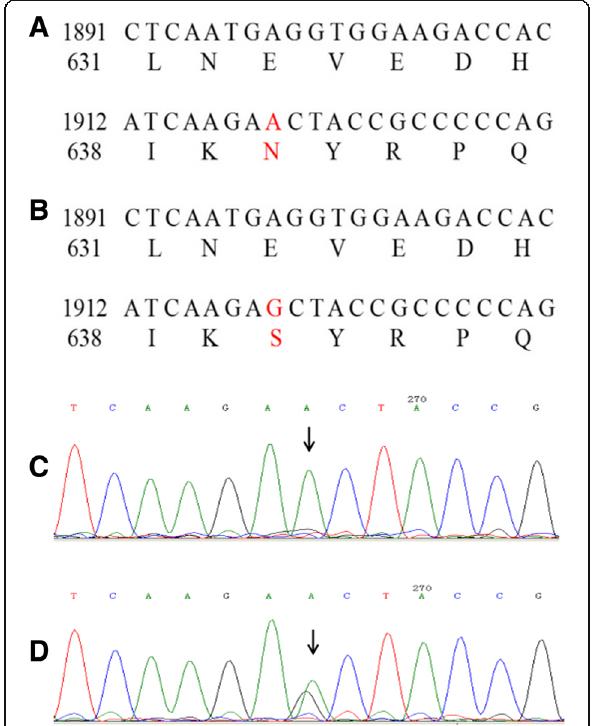
Fig. 1 Sequencing diagram of SLC12A3 gene Exon 15. a Exon 15 wild-type (DNA and amino acid sequences, GRCh37.p13); ( b ) Exon 15 heterozygous mutation type, A1919G, AAC → AGC, Asn640Ser (N640S); ( c ) Exon 15 wild-type (Sanger sequencing); ( d ) Exon 15 heterozygous mutation type (Sanger sequencing)